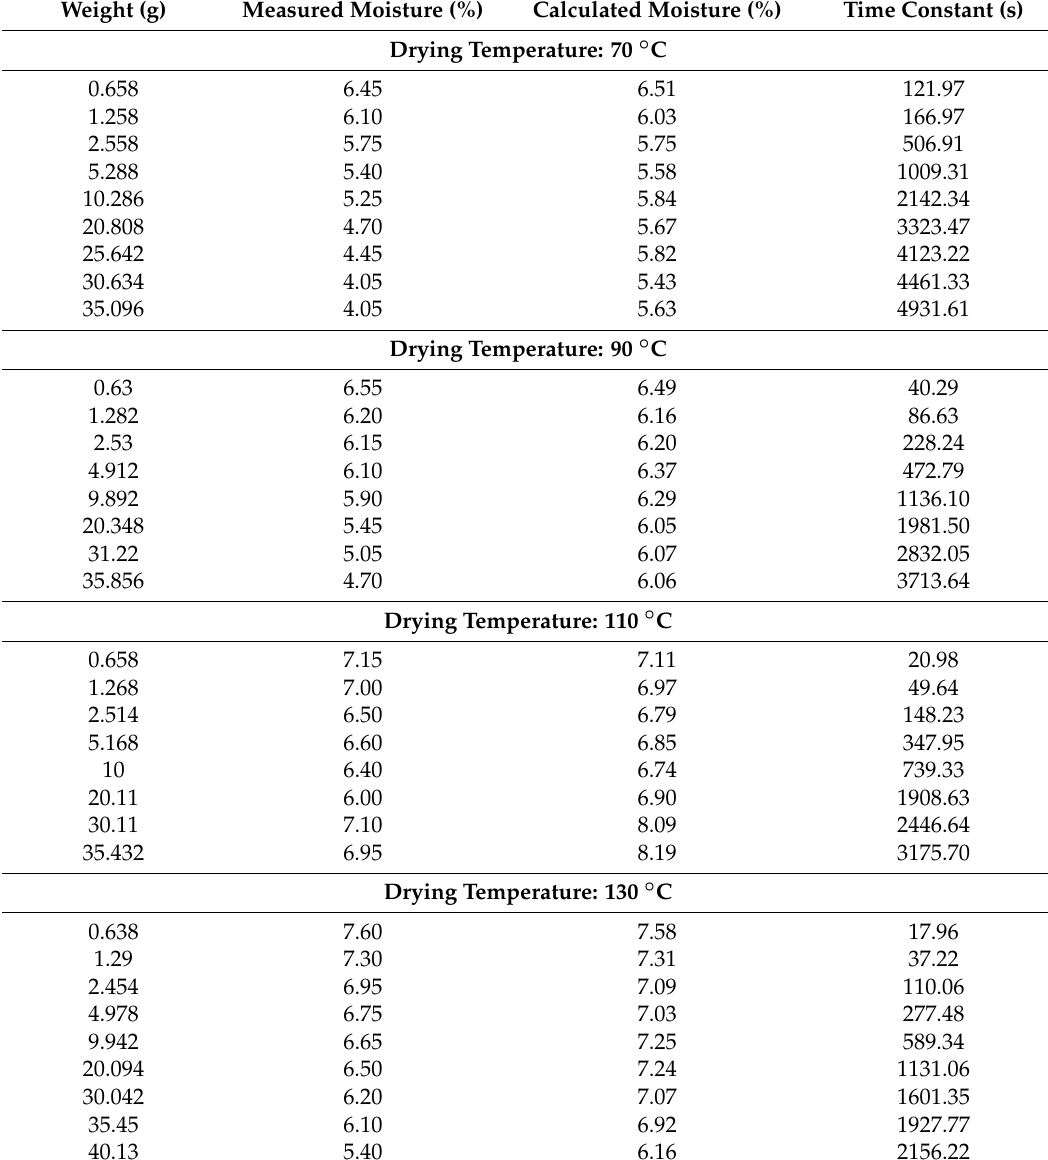
Table 2. Calculated results of the drying time constant and calculated